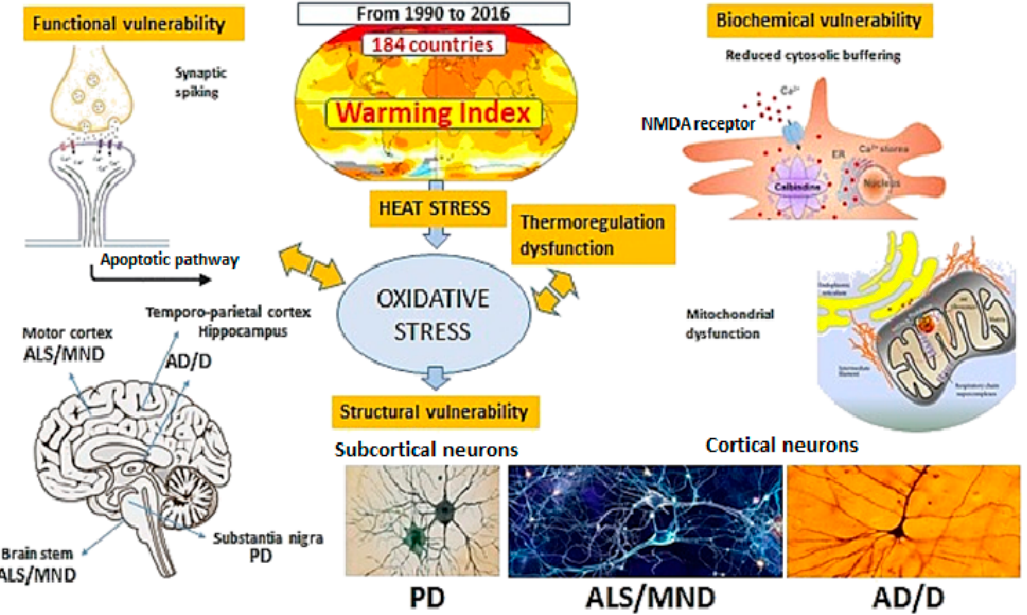
Figure 4. Scheme of the main heat stress-related types of neuronal vulnerability in neurodegenerative disease. Excessive synaptic spiking increases Ca ++ into the neurons; Calbindin modulates Ca ++ cytoplasmic levels; Prohibitin regulates mitochondrial function; cell structural differences influence neuronal susceptibility to oxidative stress.